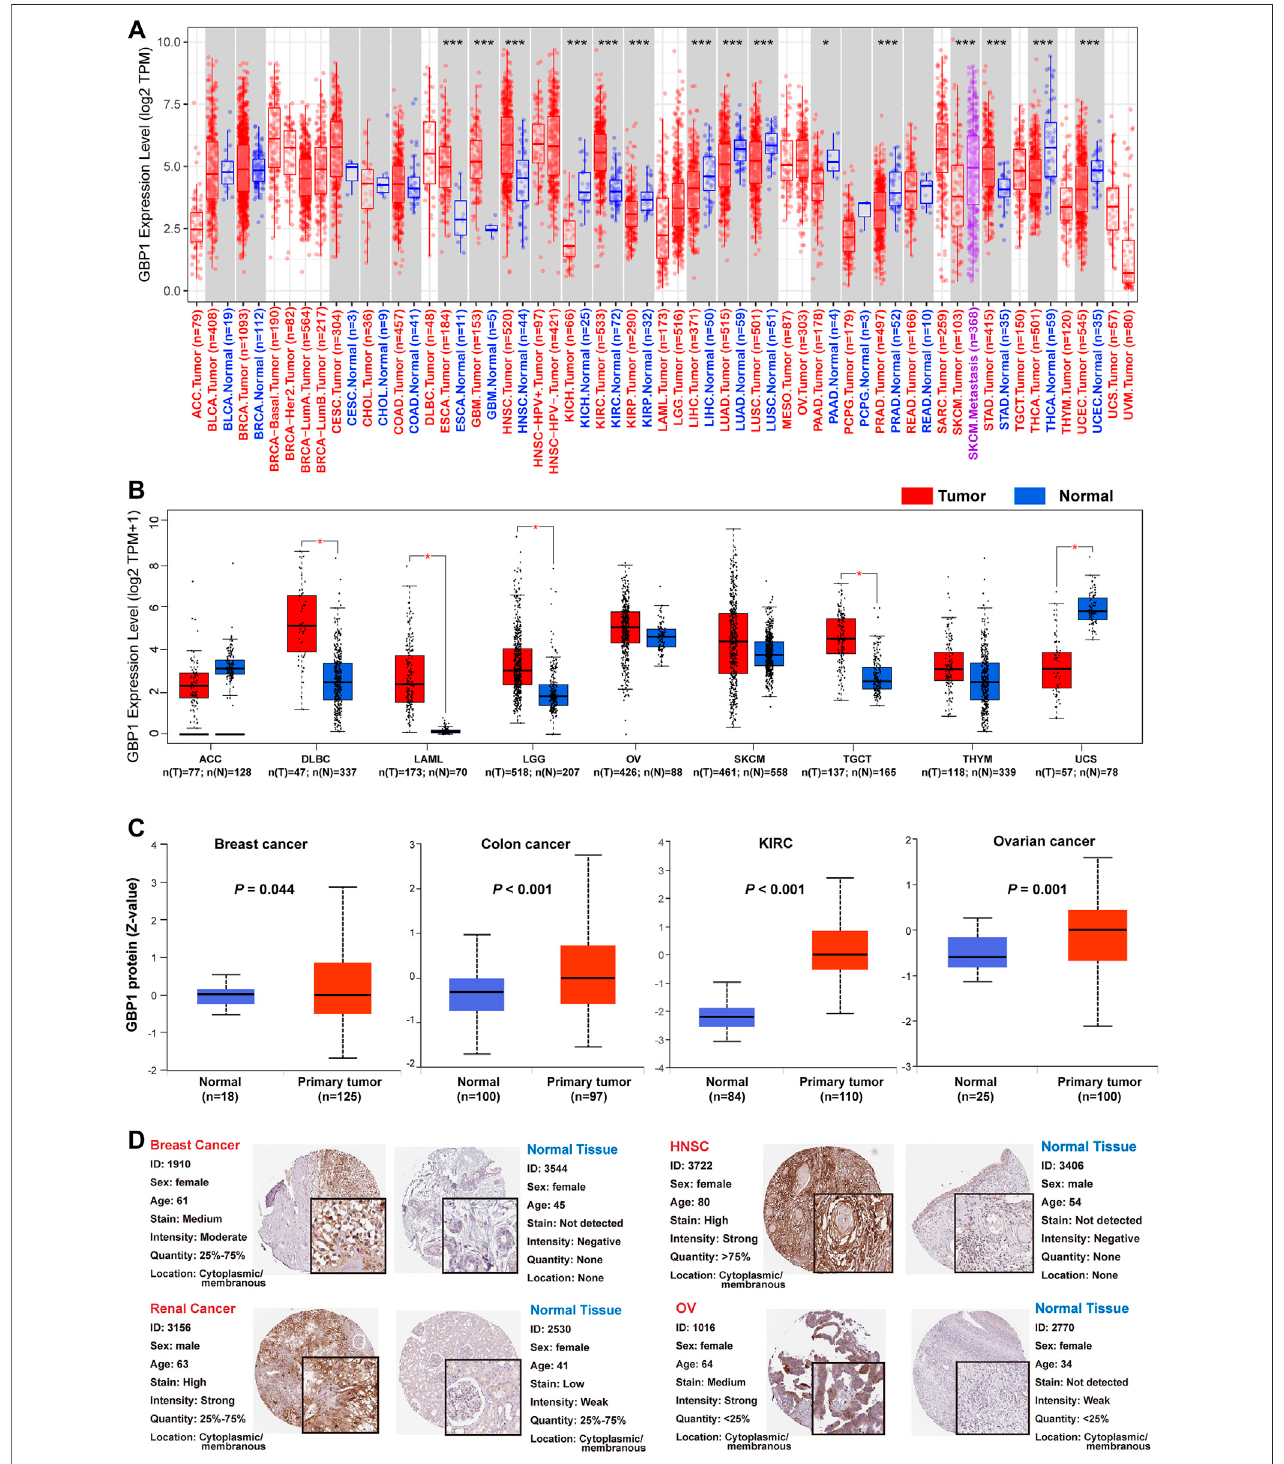
FIGURE 1 | expression level of GBP1 gene and protein in different tumors and their corresponding normal tissues. (A) The expression level of the GBP1 gene in normaltissuesandtumorsacross33TCGAcancertypesorspeci fi ccancersubtypeswasanalyzedbyTIMER2.0.* p < 0.05;** p < 0.01;*** p < 0.001. (B) Forthecancer type ofACC,DLBC, LAML, LGG, OV,SKCM, TGCT,THYM, and UCSintheTCGAdatabase,matchedTCGA normal and GTEx datawereincluded ascontrol. Boxplot depicts GBP1 expression in tumor and normal tissues. * p < 0.05. (C) The expression level of GBP1 total protein between normal tissues and primary tissues of BRCA, colon cancer, KIRC, and OV. (D) The differential expression of GBP1 proteins between tumor and normal tissues in the HPA database.